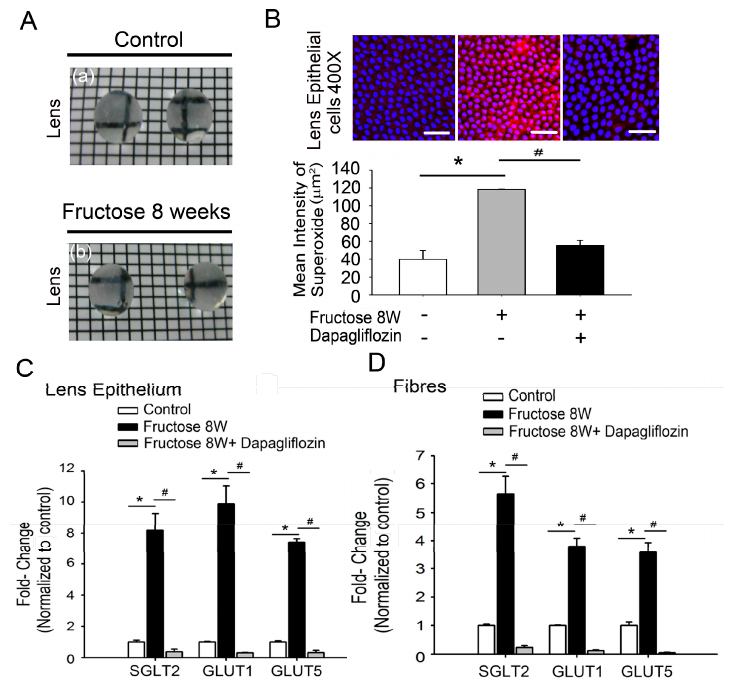
Figure 2. Glucose transporter (GLUT)-induced superoxide production in lenses of rats with fructose-induced type 2 diabetes mellitus (DM). ( A ) Lenses from the control (a) and fructose (b) groups. Rats exhibited fructose-induced type 2 DM after eight weeks (8 W). ( B ) Representative images of dihydroethidium-treated lens epithelial cells. Sections from rats with fructose-induced type 2 DM displayed significantly higher dihydroethidium fluorescence compared to the control group, whereas treatment with the sodium-glucose cotransporter 2 (SGLT2) inhibitor (dapagliflozin, 1.2 mg/kg/day) prevented this effect in fructose-fed rats. ( C – D ) Real-time polymerase chain reaction (RT-PCR) depicting SGLT2, GLUT1, and GLUT5 mRNA expression in the lens epithelium or fibers from animals with fructose-induced type 2 DM with or without dapagliflozin administration. Scale bar: 20 μ m. Data are presented as the means ± SEM ( n = 6 per group, separate experimental groups). * p < 0.05 vs. control; # p < 0.05 vs. Fructose 8 W.